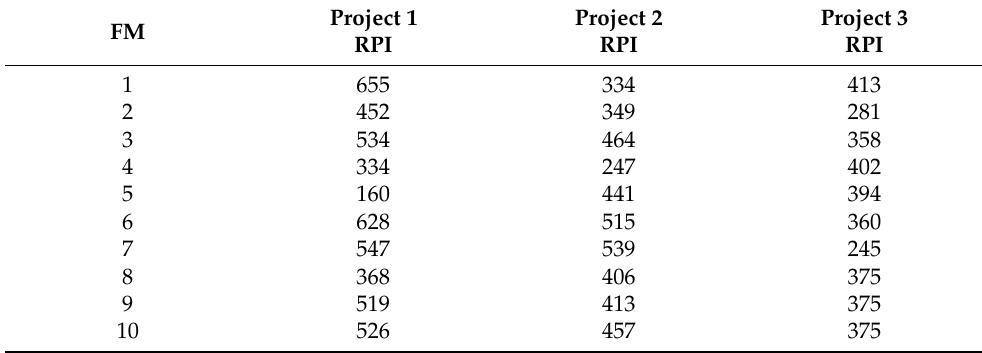
Table 7. RPI results for the three design projects considered in this study and weights S 0.4, O 0.3 and D 0.3.